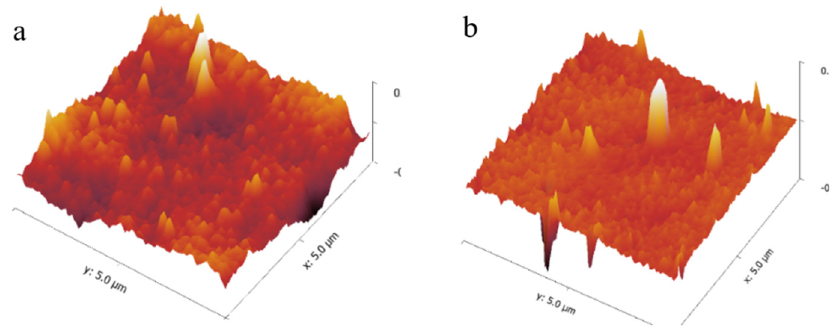
Figure 6. AFM surface profile of a virgin ( a ) and a modified (5 BLs) ( b ) UF membrane.